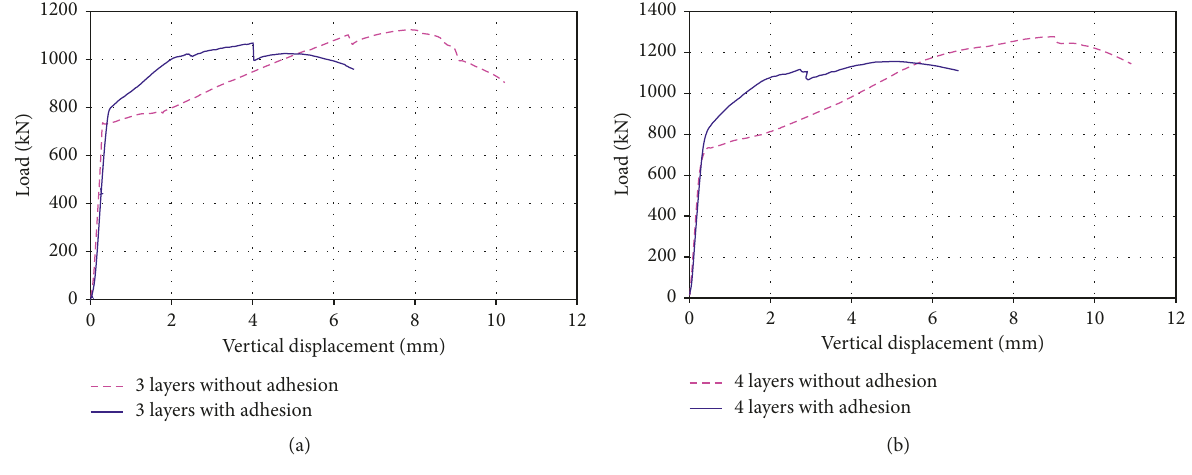
Figure 11: Effect of adhesion for 3 and 4 CFRP layers—Series II.